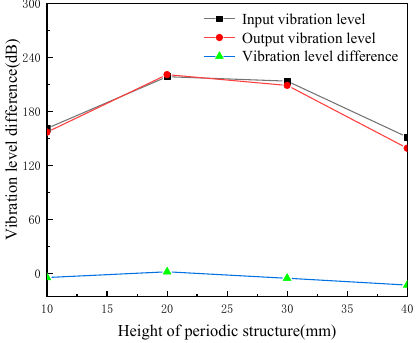
Figure 13. The effects of periodic structure height on cushioning performance (periodic structure width of 80 mm).